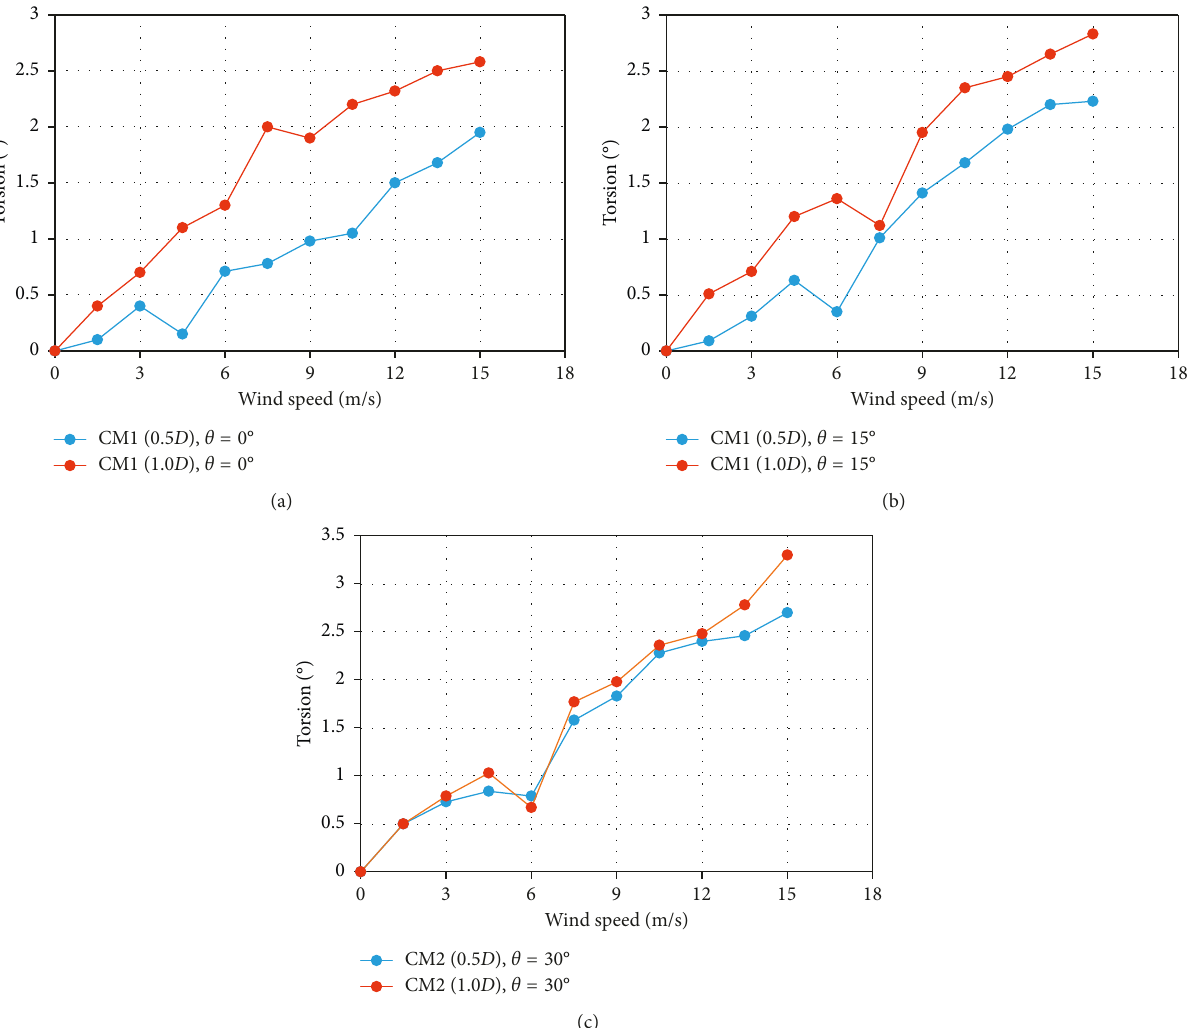
Figure 9: Variation of mean torsional response with wind speed for cable models with 0.5D and 1.0D ice thickness: (a) CM1 at θ � 0 ° ; (b) CM1 at θ � 15 ° ; (c) CM2 at θ � 30 °